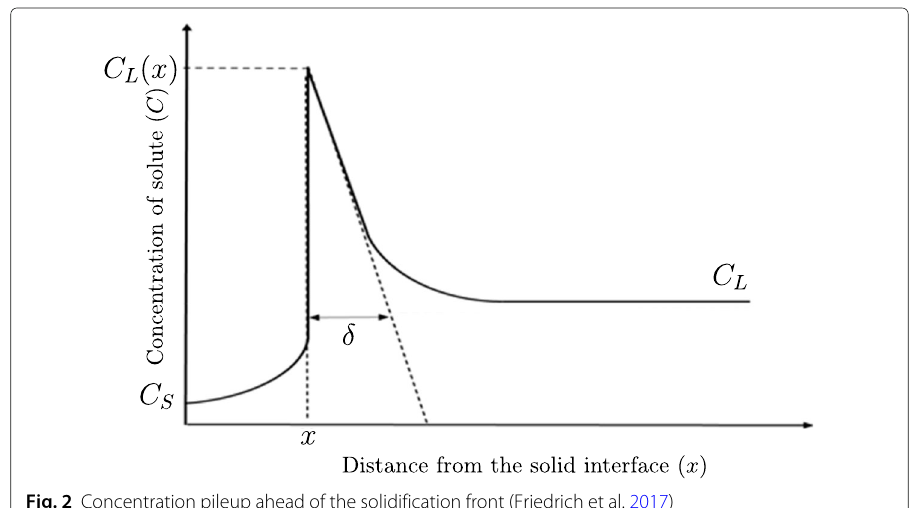
Fig. 2 Concentration pileup ahead of the solidification front (Friedrich et al. 2017)